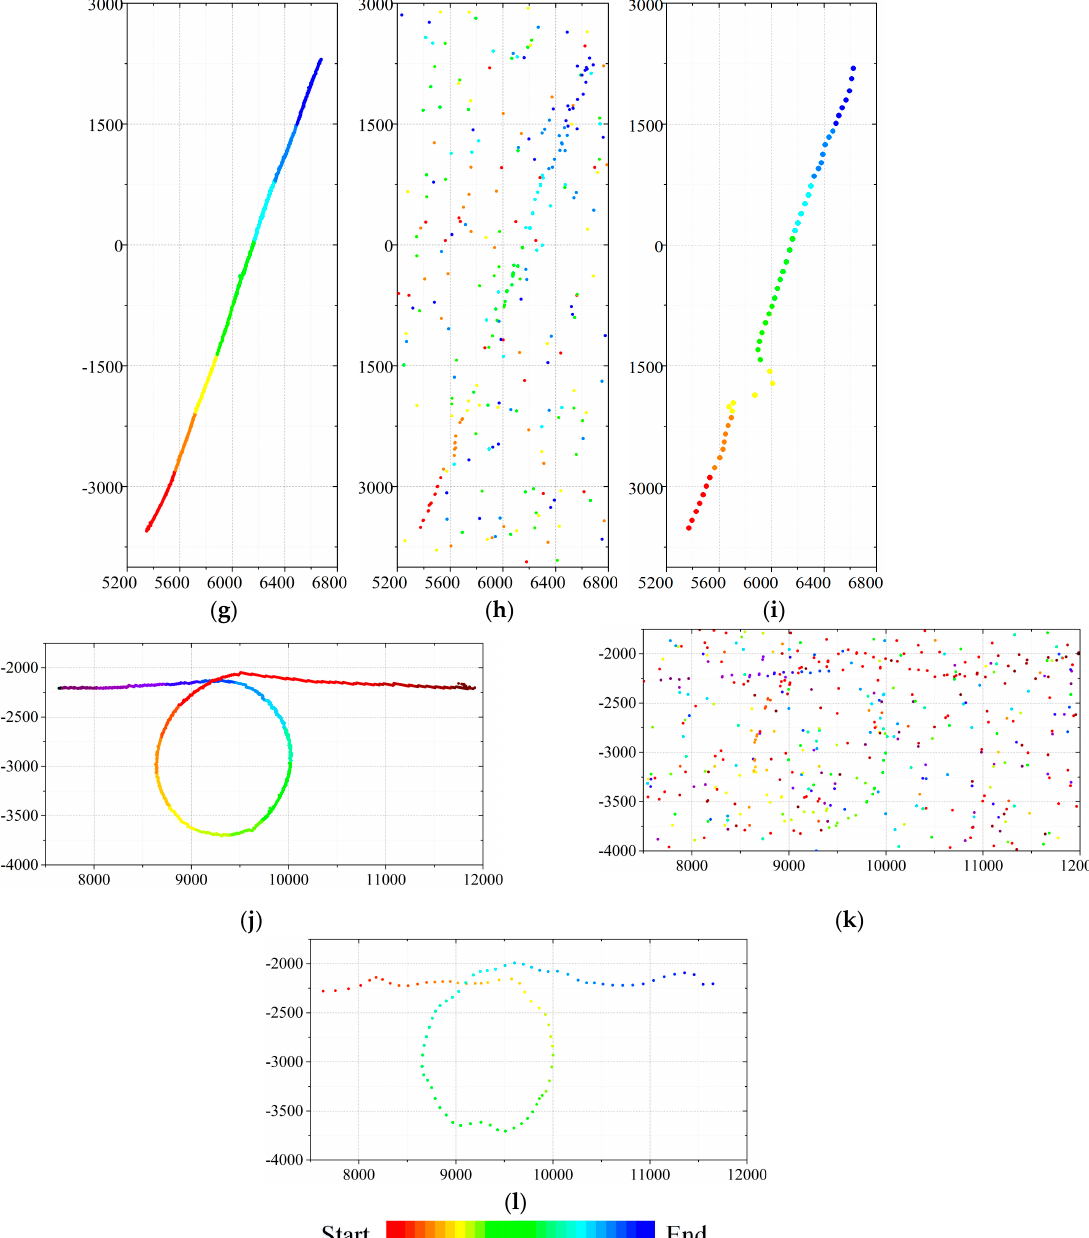
Figure 8. ( a ) Trajectory obtained by GPS in the scenario 1. ( b ) Measurements of the scenario 1. ( c ) Trajectory obtained by the GWO-TBD algorithm in the scenario 1. ( d ) Trajectory obtained by GPS in the scenario 2. ( e ) Measurements of the scenario 2. ( f ) Trajectory obtained by the GWO-TBD algorithm in the scenario 2. ( g ) Trajectory obtained by GPS in the scenario 3. ( h ) Measurements of the scenario 3. ( i ) Trajectory obtained by the GWO-TBD algorithm in the scenario 3. ( j ) Trajectory obtained by GPS in the scenario 4. ( k ) Measurements of the scenario 4. ( l ) Trajectory obtained by the GWO-TBD algorithm in the scenario 4.